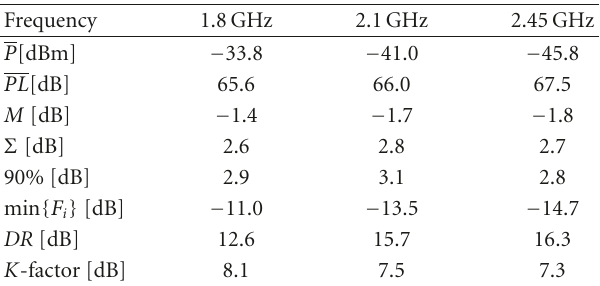
Table 3: Average fading statistics for ensemble of seats.